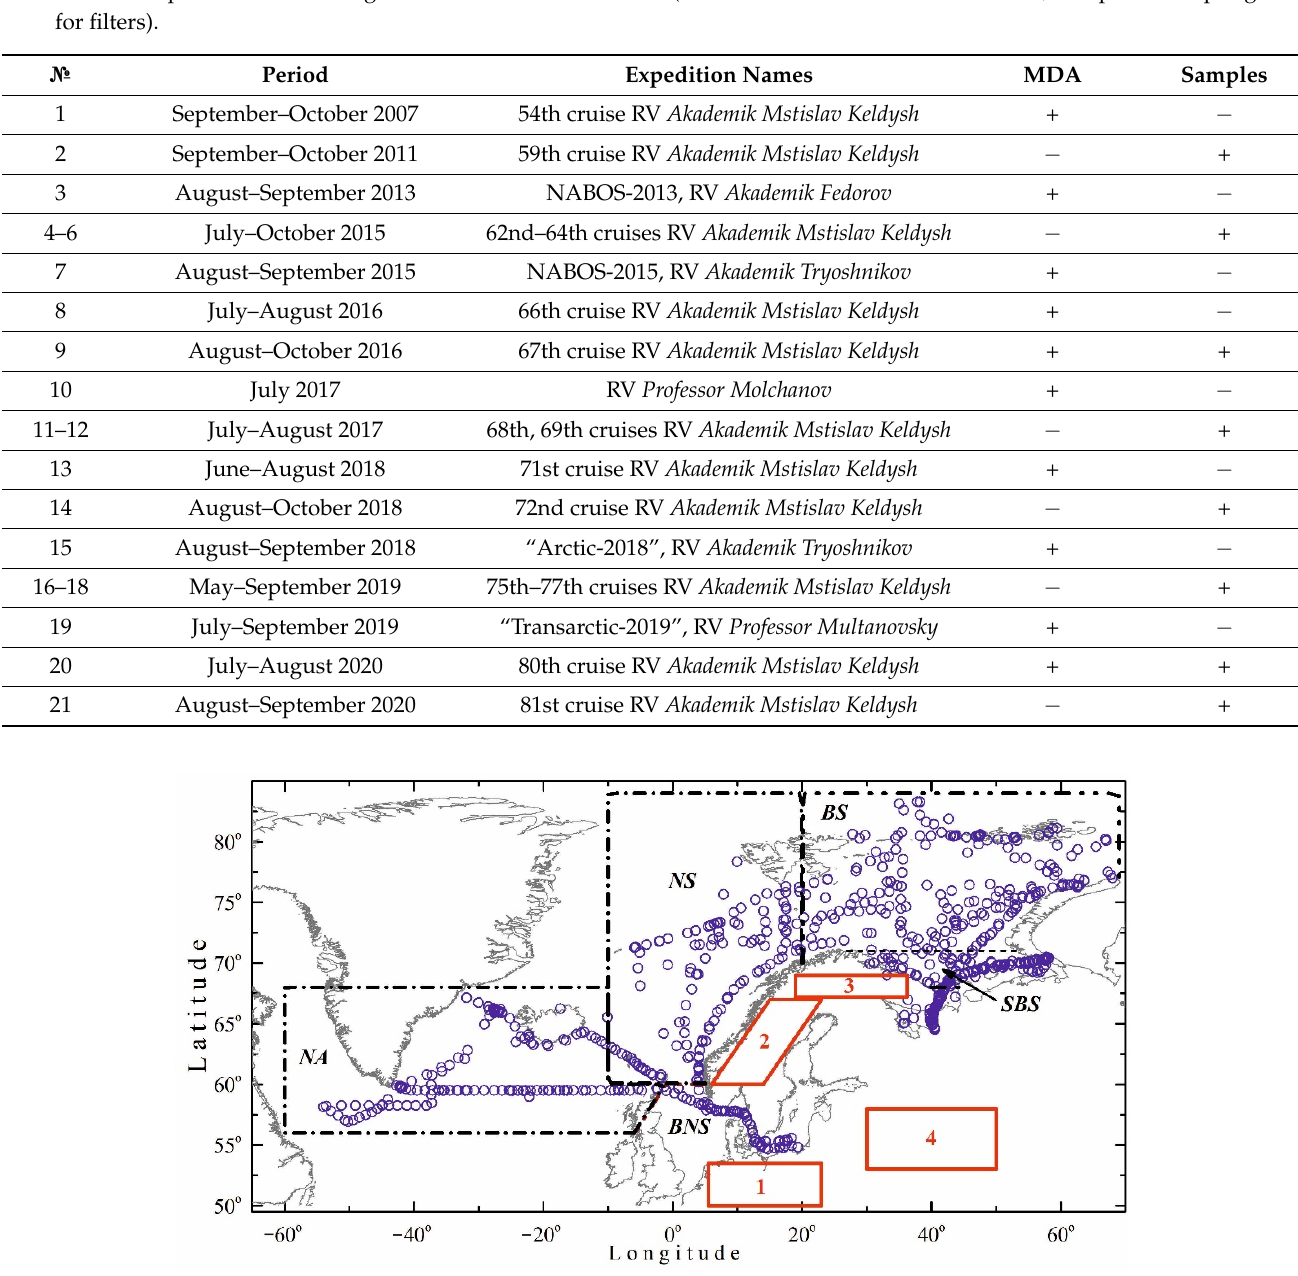
Figure 2. Route map of expeditions (measurement sites), boundaries of analyzed sea areas (dash-dotted lines) and test continental areas (red lines). Δ N/N 0.100.12 0.08 Figure 3. Histogram of the distribution of the relative amount of measurement data in different months. 3. Discussion of the Results 3.1. Spatial Distribution of Black Carbon Concentrations Figure 4 gives a general idea of how black carbon concentrations vary in different marine regions. It can be clearly seen that the concentrations and the М ВС variations are larger over the Baltic, North Seas, and in the south of the Barents Sea. Figure 5 presents the average latitude-longitude distribution of black carbon concentrations, plotted using the method of Thin Plate Spline (TPS) interpolation [43]. From the figure it can be seen that the concentrations М ВС decrease from ~220 ng/m 3 in the southern part of the North and Baltic Seas to the values less than 50 ng/m 3 in the northern regions of the ocean. In addition to the tendency of decreasing the concentration М ВС with latitude, the factor of continental impact has been well manifested. In particular, owing to its proximity to the 0.020.040.06